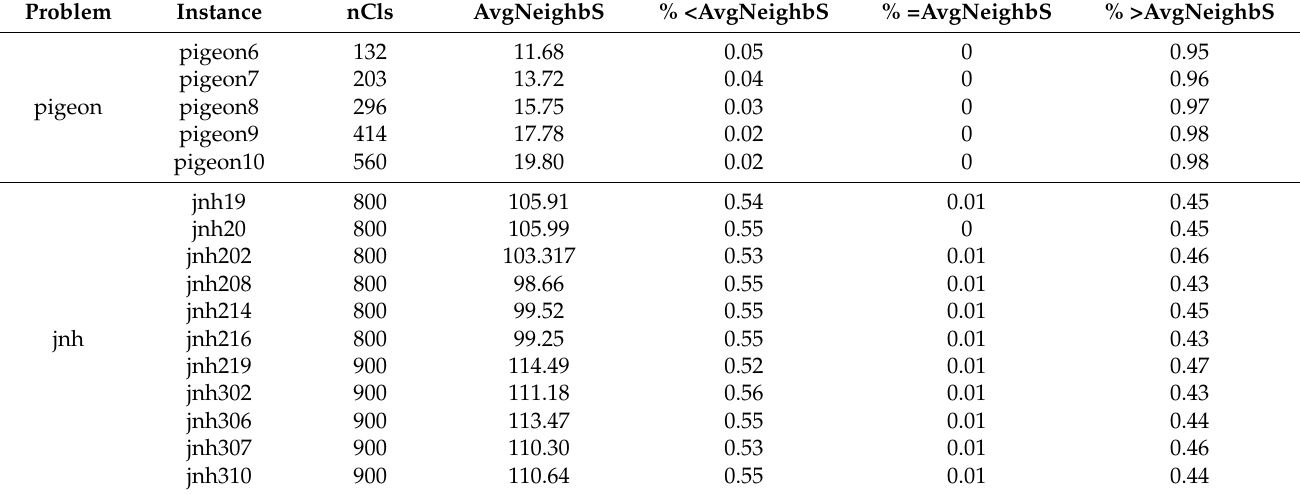
Table 1. General problems